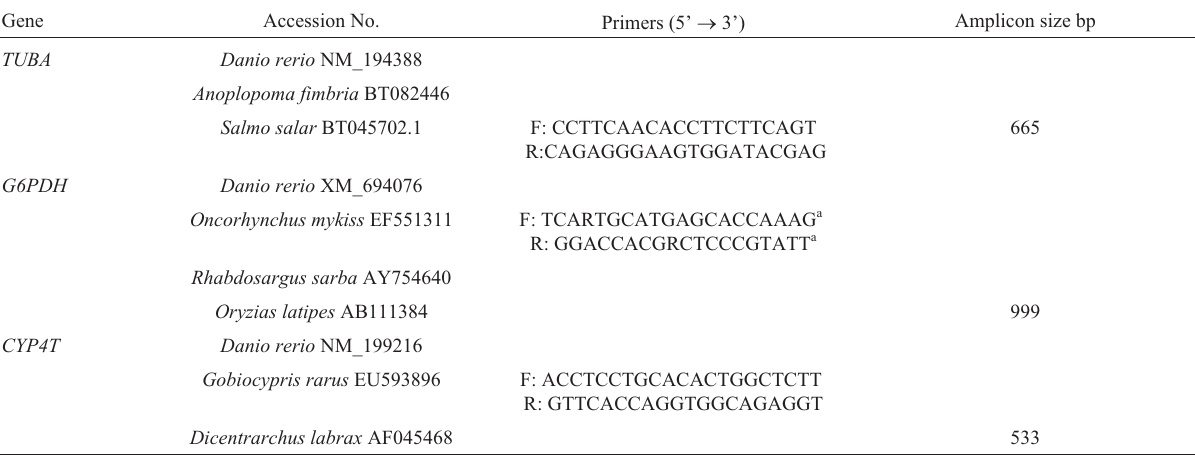
Table 1 - Primers for PCR analysis.